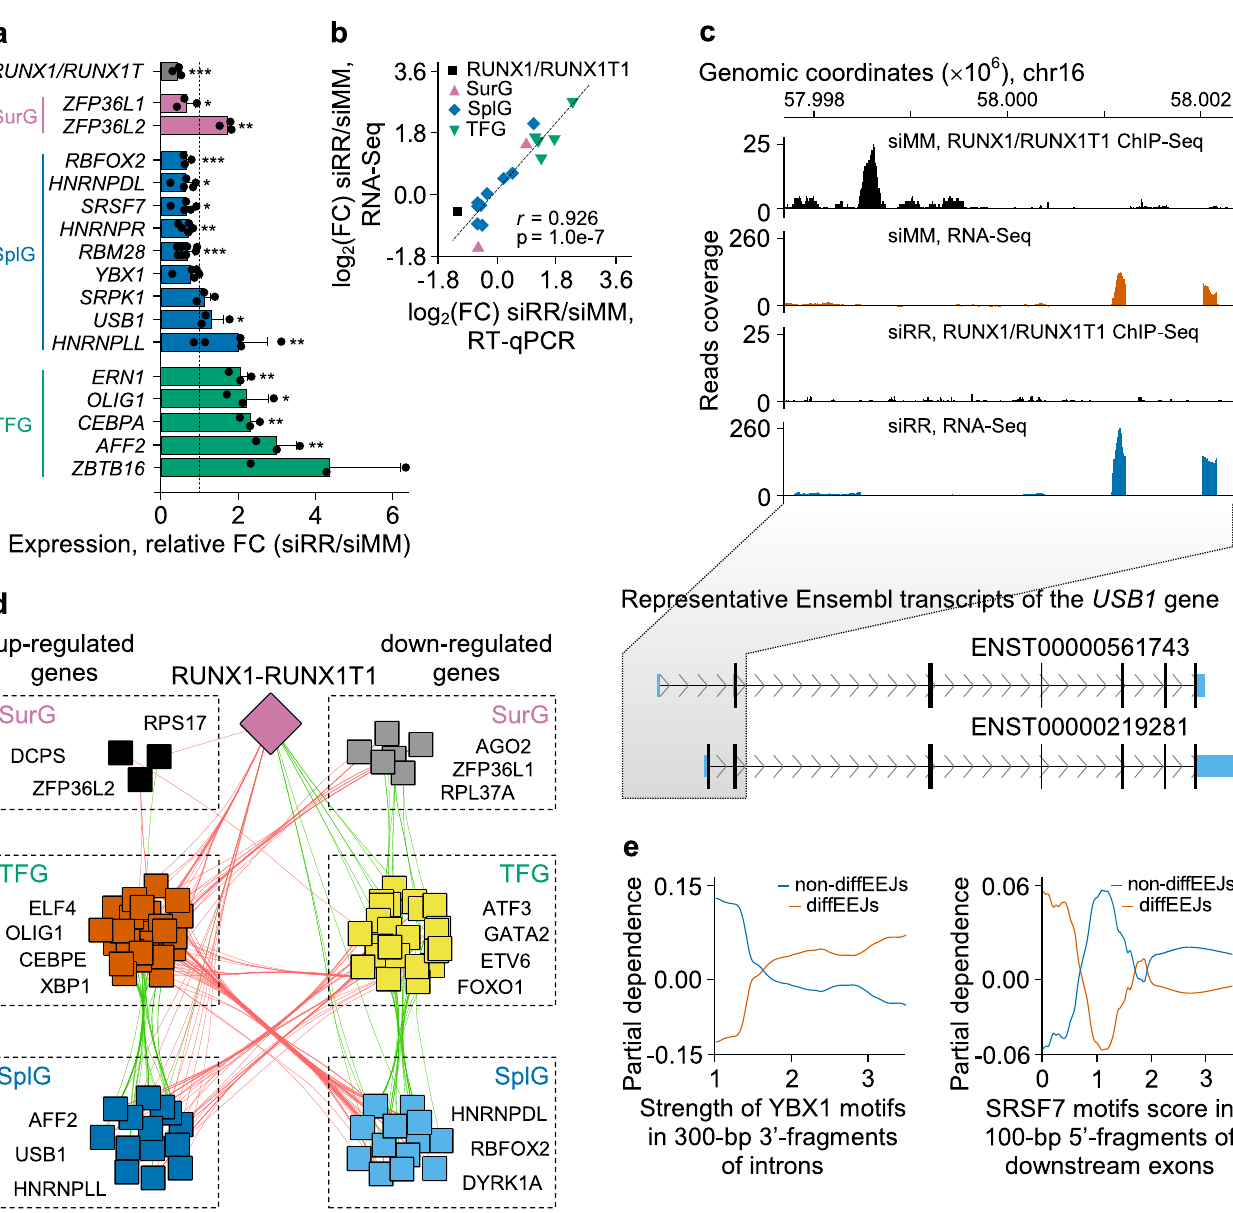
Fig. 9 RUNX1/RUNX1T1 indirectly affects differential splicing in Kasumi-1 cells. a Bar graph showing the impact of RUNX1/RUNX1T1 knockdown on the expression of mRNA surveillance genes (SurG), genes encoding splicing factors (SplG) and transcription factors genes (TFG) associated with splicing. Bars represent mean ± SD of three independent qPCR experiments. * p < 0.05, ** p < 0.01, *** p < 0.001 with one-tailed Student ’ s t test. b Graph showing correlation between RNA-seq and q-PCR validation of differential RNA processing gene expression. c IGV screen shot depicting RUNX1/RUNX1T1 binding and RNA-Seq reads for the USB1 locus. d Cytoscape scheme showing RUNX1/RUNX1T1-centered gene regulatory network of genes encoding splicing regulators and mRNA surveillance factors. Terms “ upregulated genes ” and “ downregulated genes ” refer to a change in the expression of the genes after RUNX1 / RUNX1T1 knockdown. Positively and negatively co-expressed genes linked by green and red edges, respectively. Examples of the genes from each group are shown in the respective dashed boxes. e Effect of the strength of the motifs to splicing factors on the probability of non-diffEEJs and diffEEJs in leukemia cells. These partial dependence plots are based on the results from 1,000 independent runs of the random forest meta-classi fi er and 1000 classi fi cation trees per random forest per